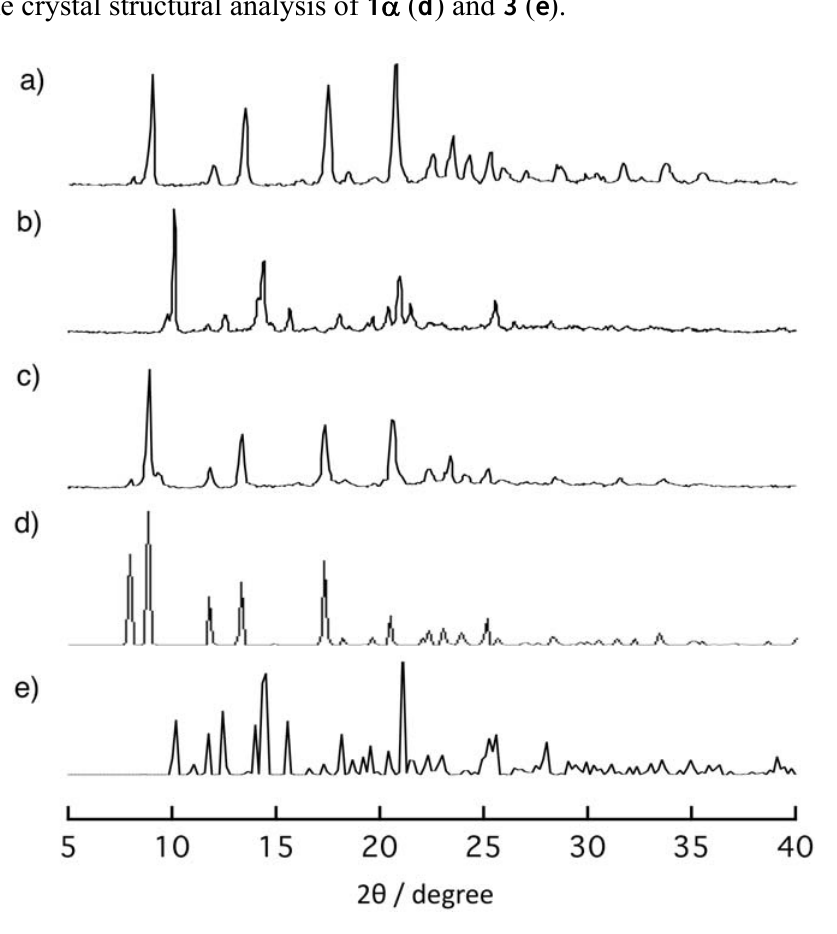
Figure 5. X-ray powder diffraction (XRPD) patterns of solid sample of 1 ( a ), its dried sample obtained on heating at 130 °C under reduced pressure ( b ), and the powder obtained by exposure of EtOH vapor to the dried sample ( c ) for three days. The simulation patterns based on the crystal structural analysis of 1  ( d ) and 3 ( e